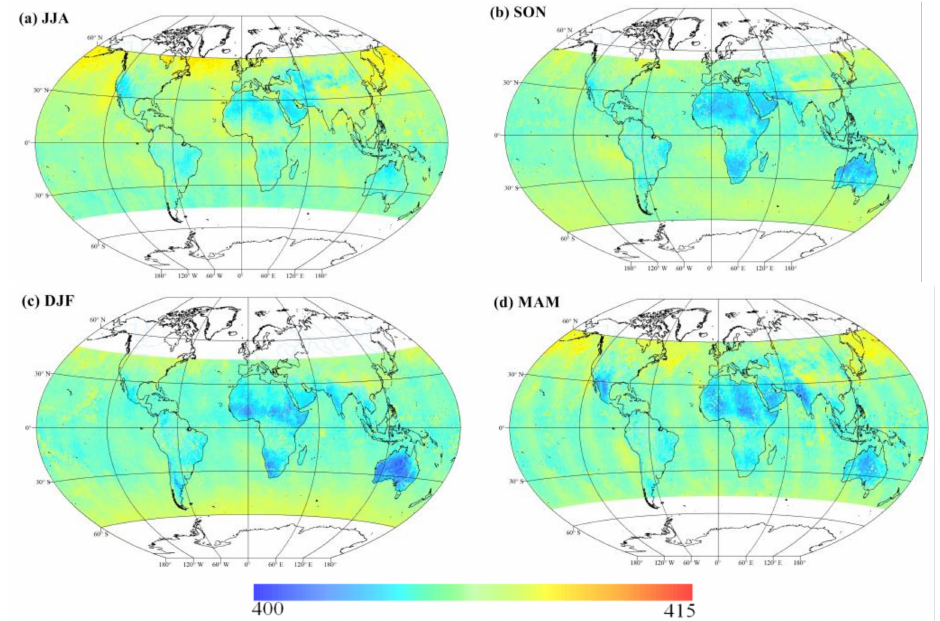
Figure 11. Seasonal CO2 at 300hPa from May 2018 to April 2019 for ( a ) June-July-August (JJM), ( b ) September-October-November (SON), ( c ) December-January-February (DJF), and ( d ) March- April-May (MAM), with 1 ◦ latitudinal